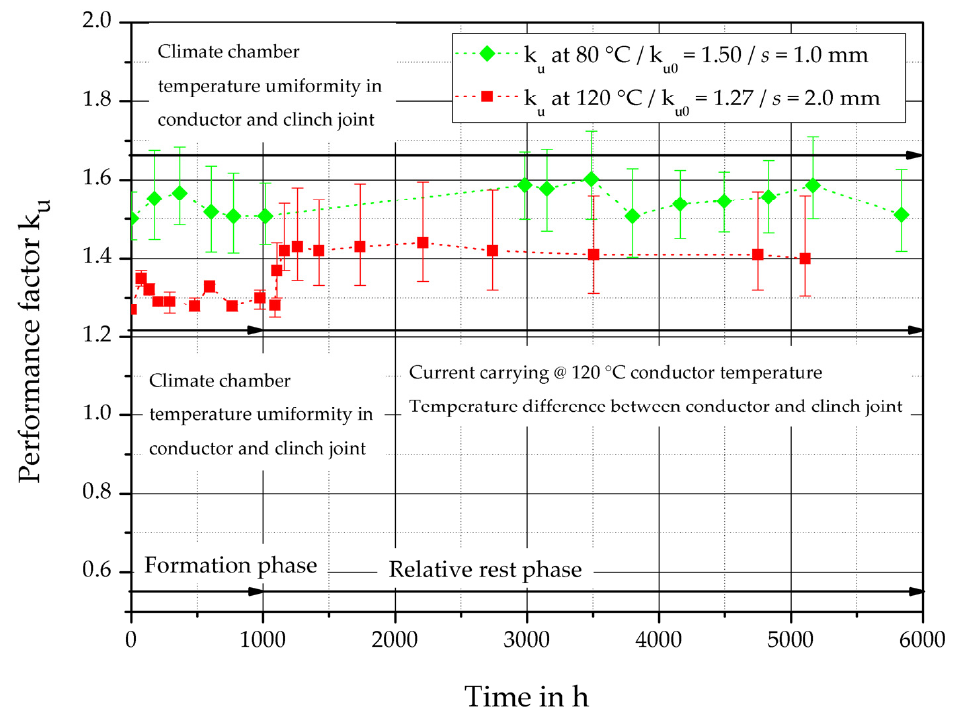
Figure 8. Performance factor ku of clinch joints with a contact partner made of Cu-ETP as a function of time and temperature .